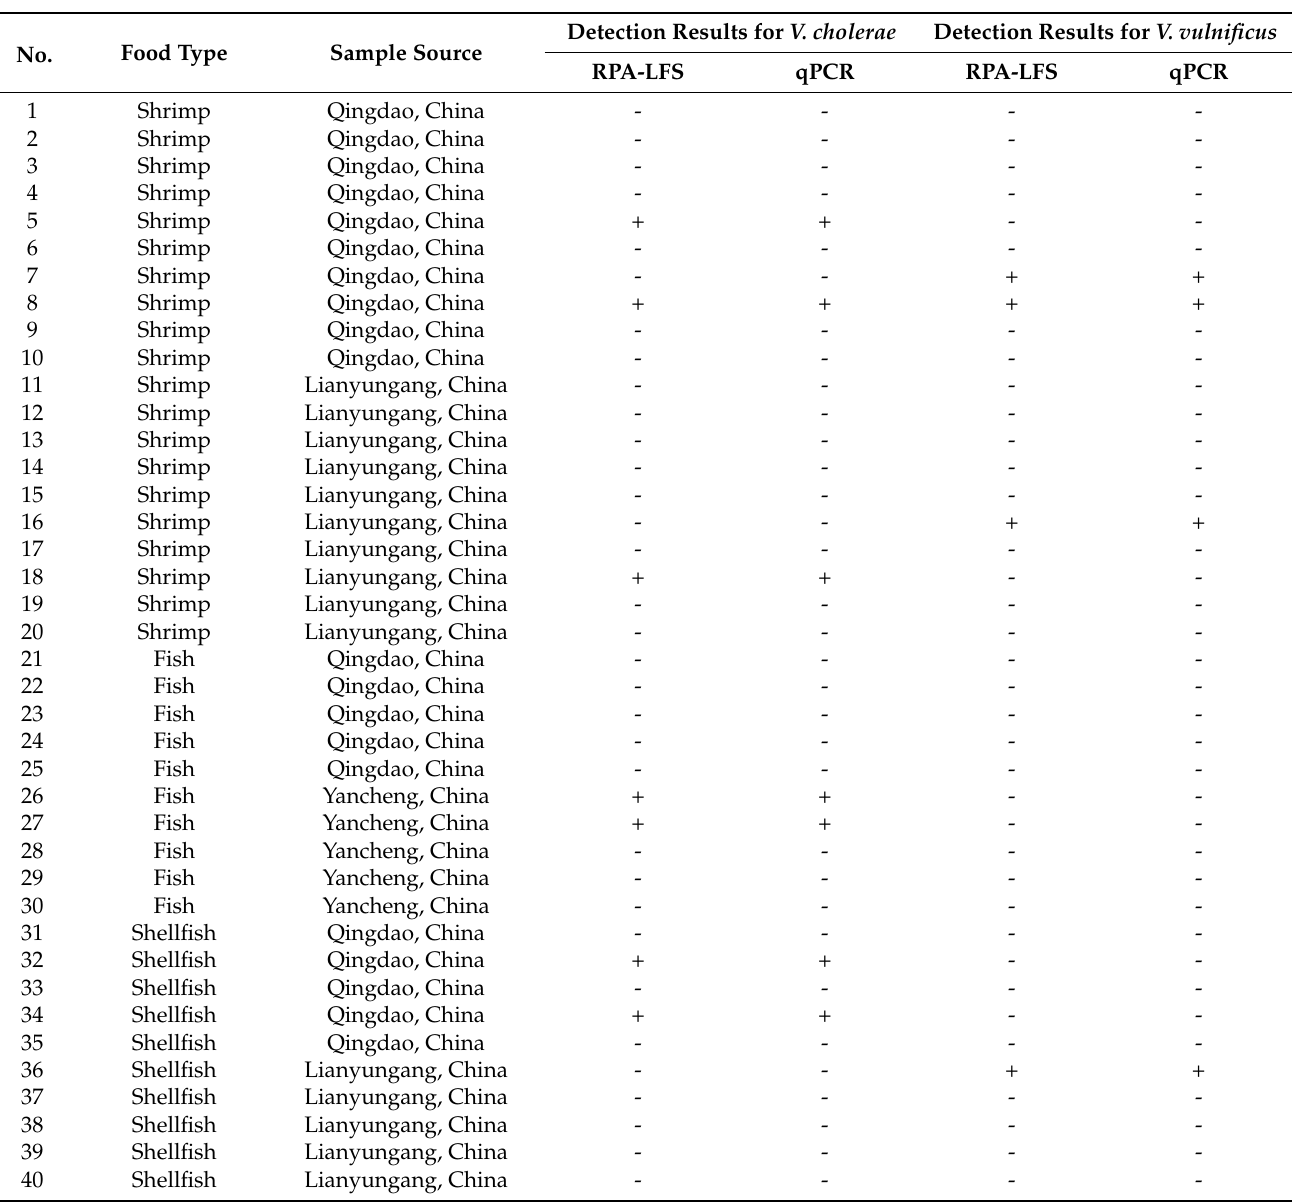
Table 3. Detection of V. cholerae and V. vulnificus in clinical